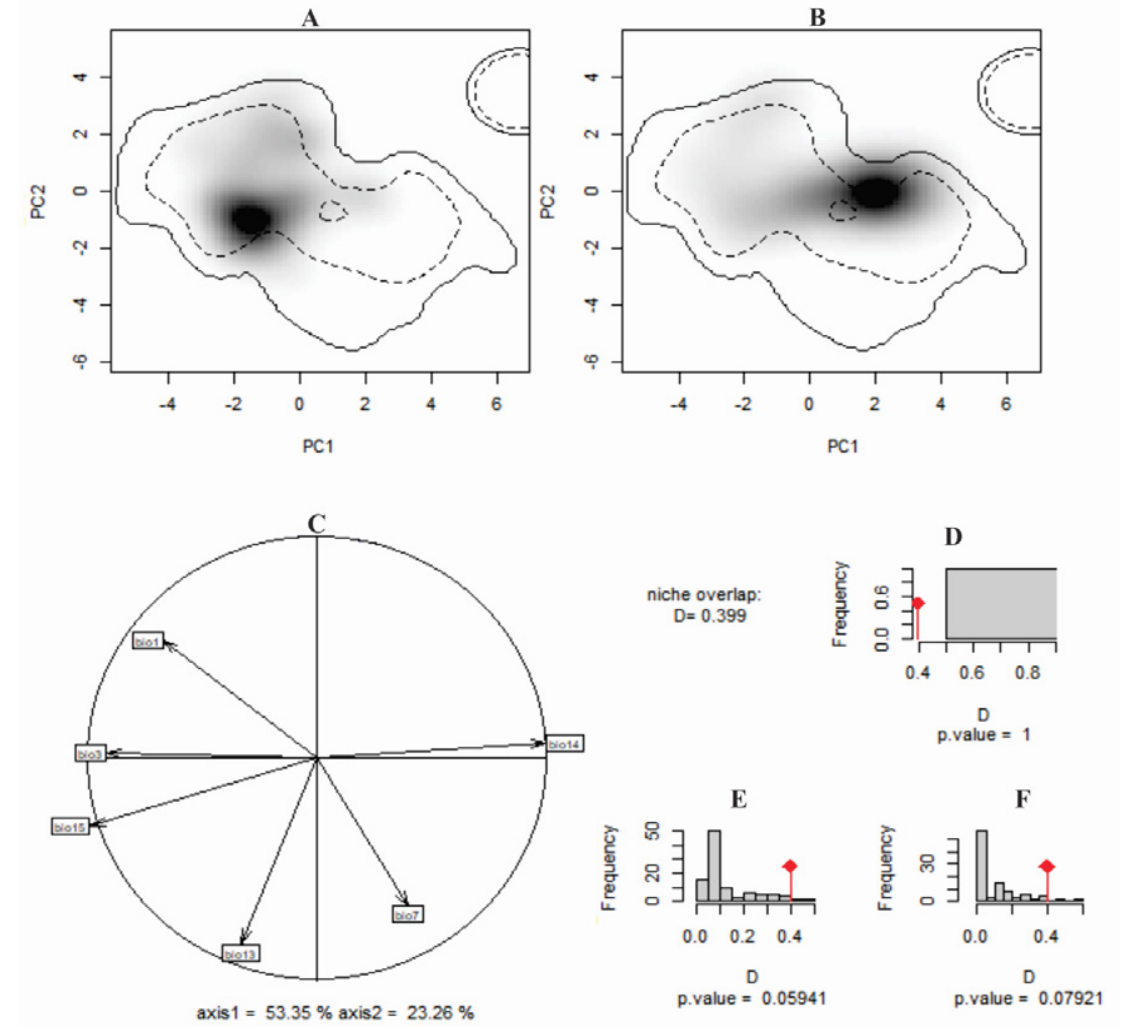
Fig 3 . Current climatic niches occupied by the two subspecies of Melipona quadrifasciata. Niche occupied by M. q. anthidioides (A) and M. q. quadrifasciata (B) along the two-first axes of the PCA (see (C) for details). Grey shading represents the density of the occurrences of the subspecies by cell. The solid and dashed contour lines illustrate, respectively, 100% and 50% of the available environment. (C) Contribution of the climate variables to the first-two axes of the PCA (bio1: annual mean temperature, bio3: isothermality, bio7: annual temperature rate, bio13: precipitation of the wettest month, bio14: precipitation of the driest month, and bio15: precipitation seasonality), and contribution of the two-first axes to data variation. (D) Histogram of the observed niche overlap D (D = 0.399) (bars with a diamond) and simulated niche overlaps (grey bars). (E) Niche similarity of M. q. quadrifasciata to M. q. anthidioides , and (F) niche similarity of M. q. anthidioides to M. q. quadrifasciata